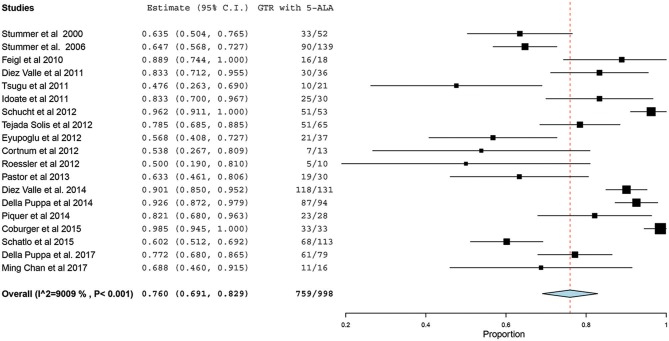
Forest plot graph representing the meta-analysis of gross total resection (GTR) rate (95% confidence interval [CI]) among patients with high-grade glioma, including primary and recurrent cases, treated using 5-aminolevulinic acid (5-ALA)–guided surgical resection. Used with permission from Barrow Neurological Institute, Phoenix, Arizona.